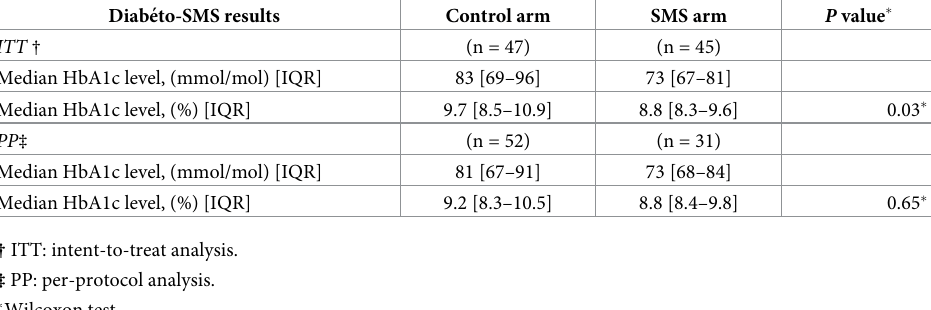
Table 2. Median HbA1c level at 6 months.